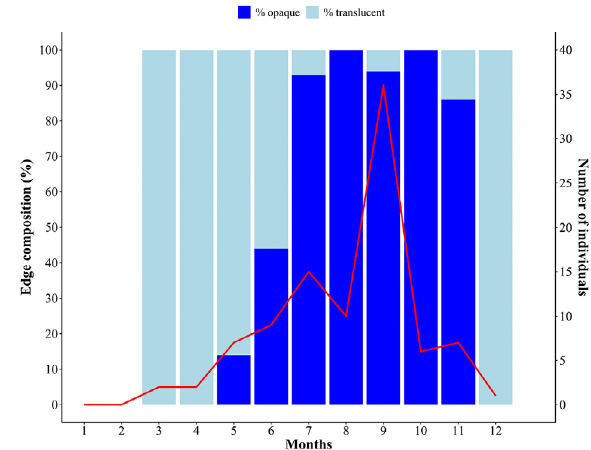
Fig. 4. – Number of individuals (red line) and monthly edge composition (%) in otoliths of Trachinotus ovatus .